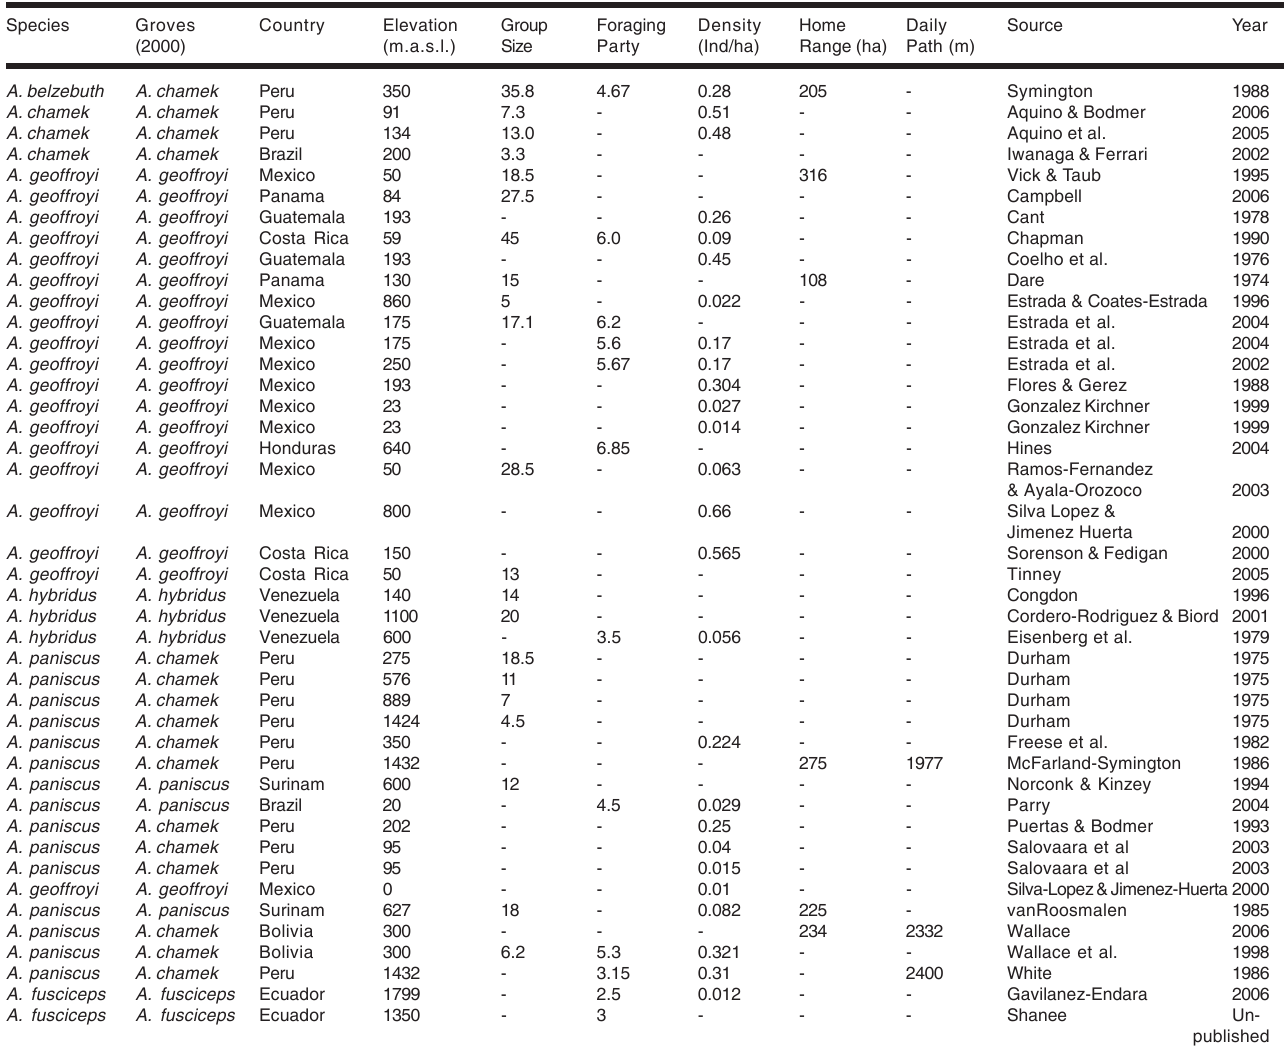
Table 1. Spider monkey group structure and elevations, studies used in this